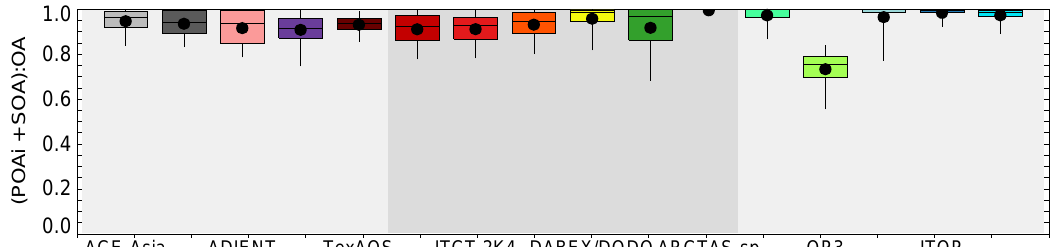
Fig. 8. OOA:OA simulated with GEOS-Chem for 17 aircraft field campaigns, where OOA is defined as the sum of SOA and hydrophilic POA. Means of the gridded model concentrations sampled along the aircraft profiles are shown as a solid dot, median as a horizontal line. The boxes denote 25th and 75th percentile, whiskers denote 5th and 95th percentile.